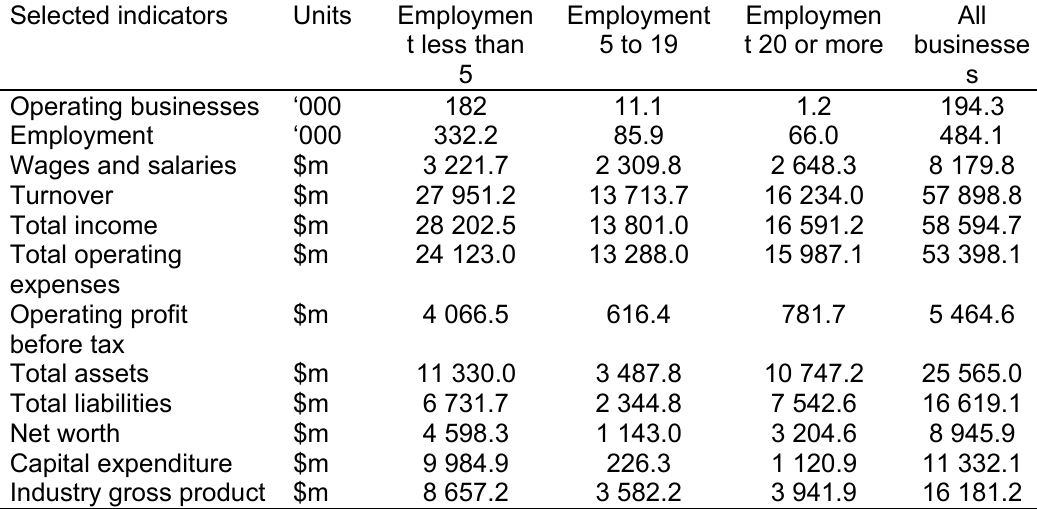
Table 3. Summary of Performance by Business Employment Size.